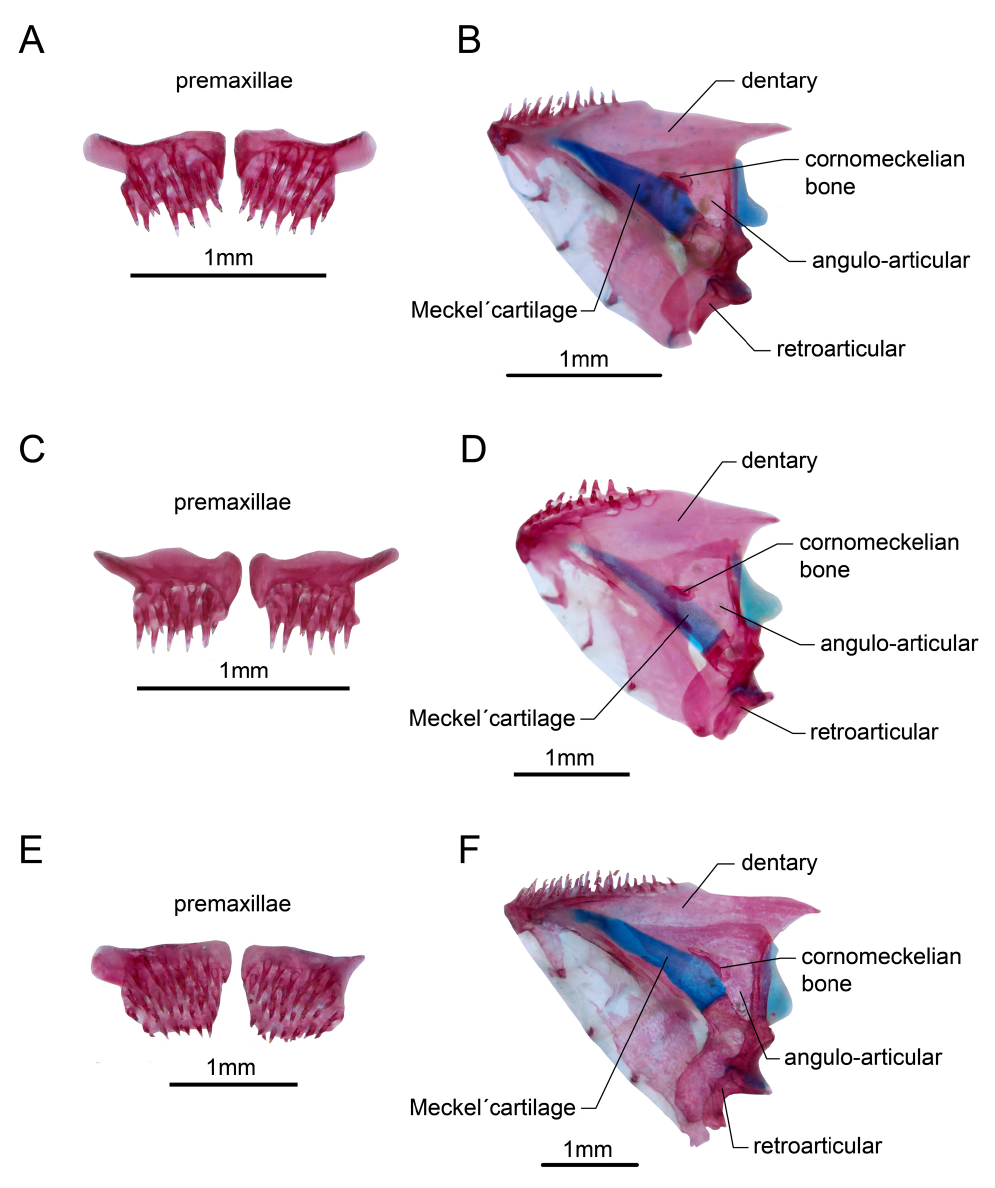
FIGURE 3 | Osteological elements of Eigenmannia bumba , MZUSP 123709: A . Premaxillae, B . Lower jaw; Eigenmannia cacuria , UFPB 11916: C . Premaxillae, D . Lower jaw; and Eigenmannia robsoni , UFPB 8202: E . Premaxillae, F . Lower